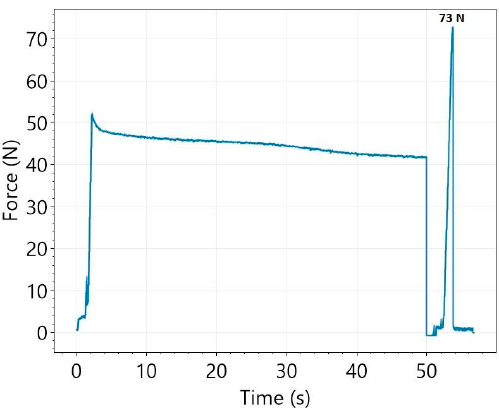
Figure 3. Process of measurement of mucoadhesion force (Ref).